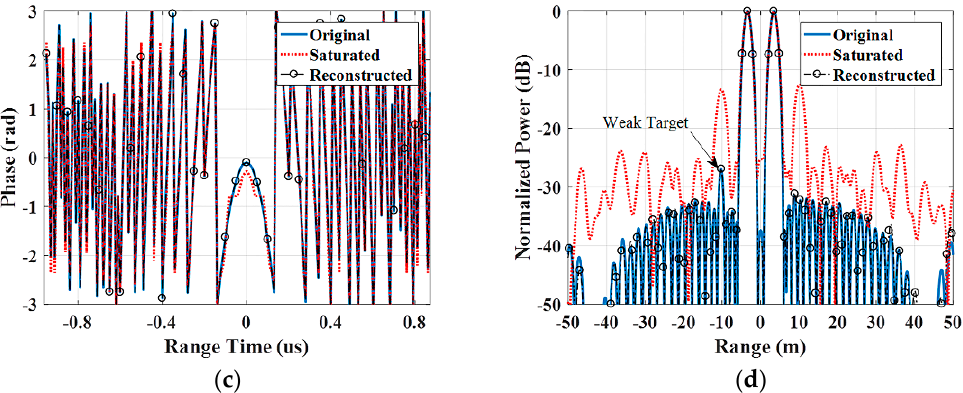
Figure 15. Simulation of 1D pulse compression with a 50% saturation factor. ( a ) The real part of the raw data. ( b ) The amplitude of the raw data. ( c ) The phase of the raw data. ( d ) Pulse compression results with a Hamming window.